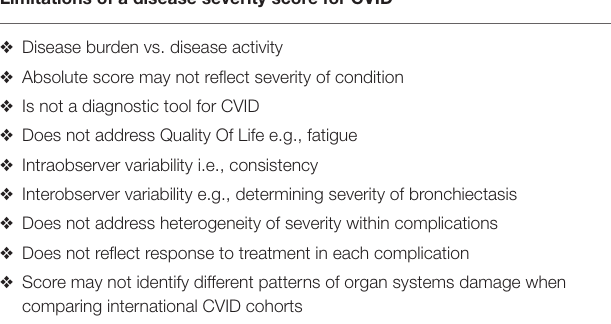
TABLE 2 | Potential advantages of a disease severity score for CVID. Potential advantages of a disease severity score for CVID